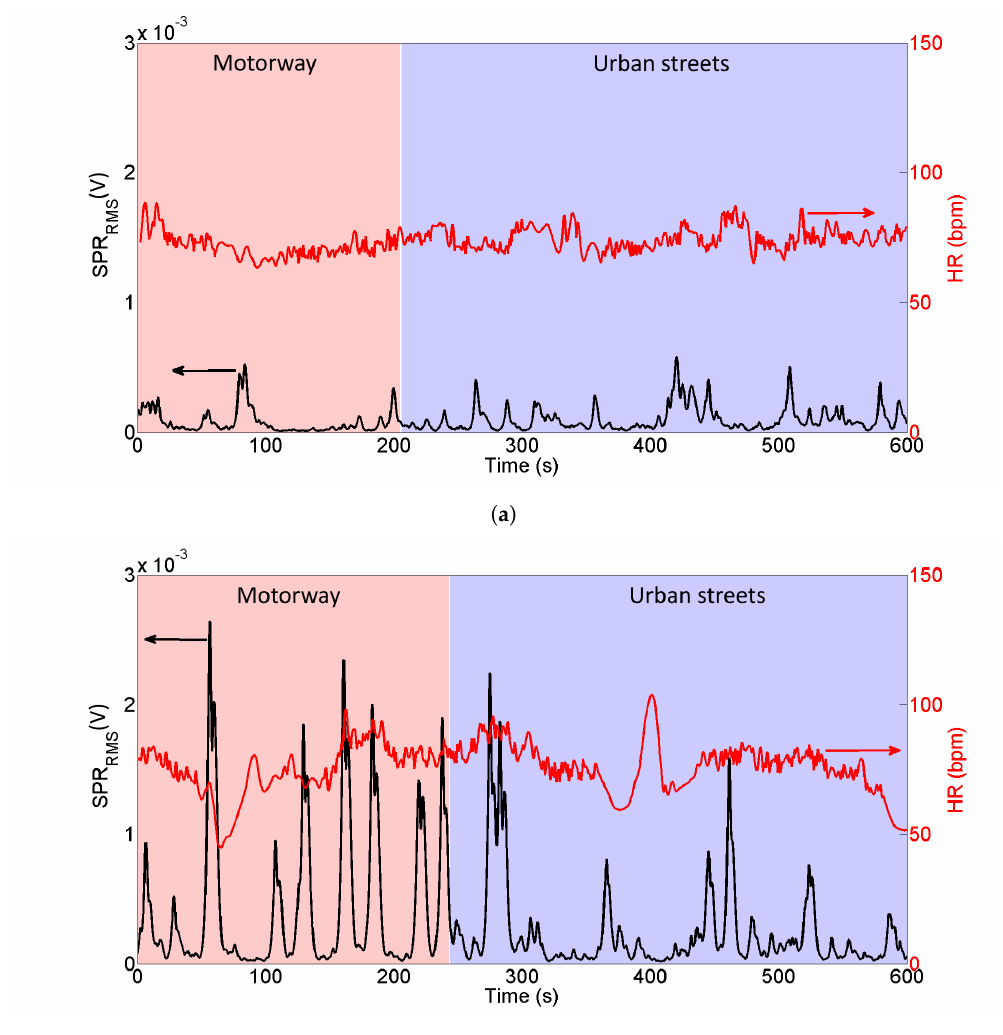
Figure 12. Acquired traces from a subject driving without traffic ( a ), and with aggressive traffic ( b ). Black line (left axis) represents SPR RMS signal, red line (right axis) represents HR signal. It is evident that SPR peaks are by far higher during traffic test and HR shows a higher